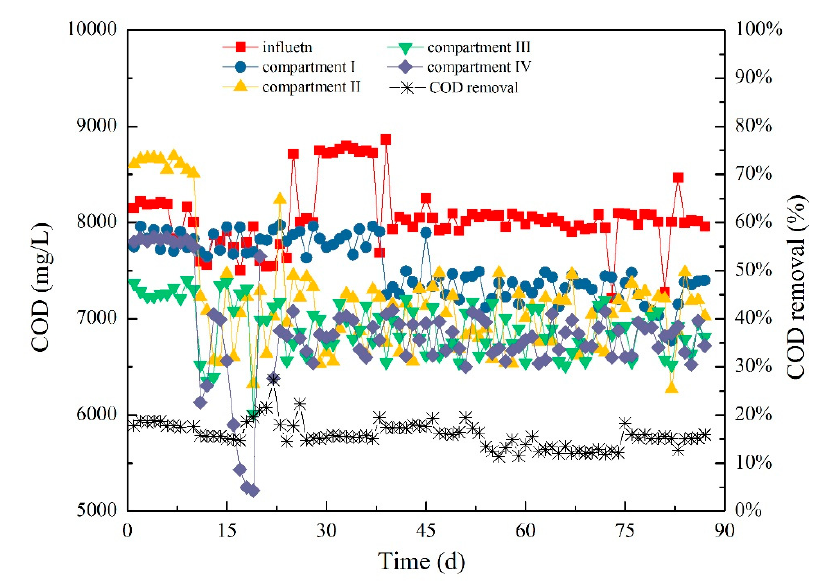
Figure 14. Variation of COD in each compartment.